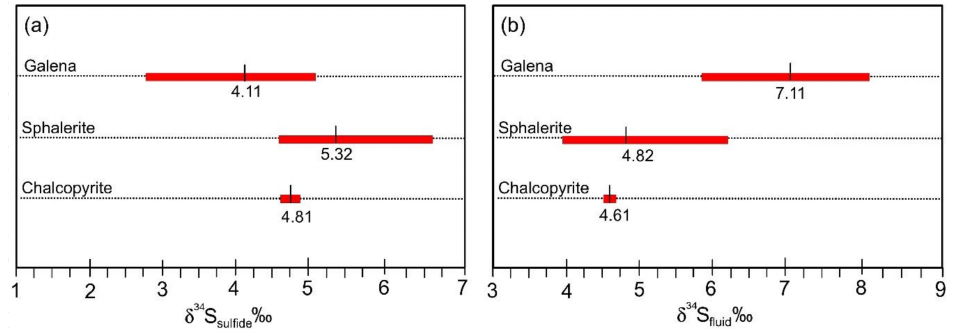
Figure 22. Range (bars) and average (numbers) of δ 34 S sulfide ( a ) and calculated δ 34 S H2S ( b ) values in the Shah-Ali-Beiglou